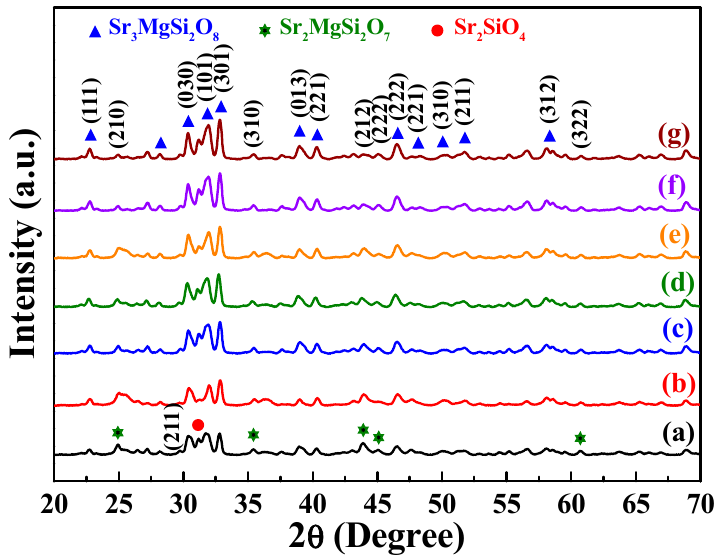
Figure 1. XRD patterns of the [Sr 0.99 Eu 0.01 ] 3 MgSi 2 O 8 phosphors sintered for different durations: (a) 1,